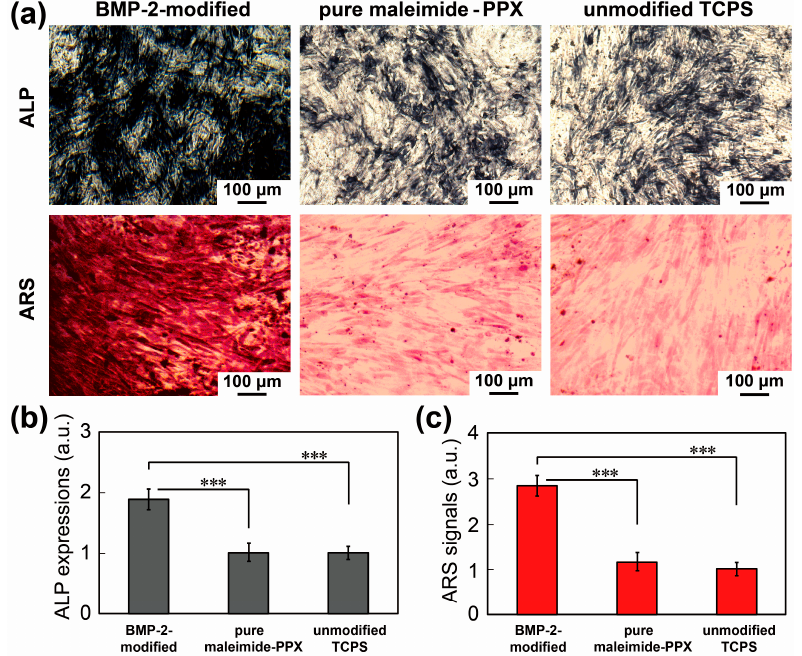
Figure 3. The osteogenesis activities of hADSCs were examined on the modified surfaces with immobilized BMP-2 growth factor protein. Pure maleimide-PPX coating surfaces and unmodified tissue culture polystyrene (TCPS) surfaces were used for the comparison. ( a ) The early stage osteogenesis marker, ALP expression, was analyzed at day 10, and the mature stage marker, calcium deposition, was observed at day 21 using alizarin red staining (ARS). The results of statistical analyses of the quantified ( b ) ALP signals and ( c ) ARS signals were also compared for the studied surfaces. The data bars represent the mean value (n = 3) and the standard deviation (±SD) based on three independent experiments. The significance level *** stands for *** p < 0.001, and is shown by the results of the unpaired t -test.